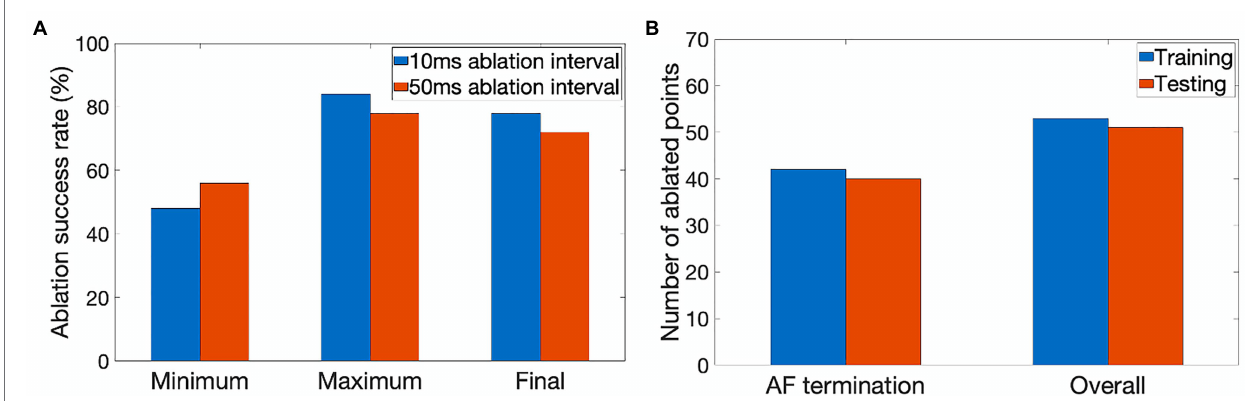
FIGURE 4 | Performance characteristics of the ablating agent. (A) The minimum, maximum and final ablation success rate achieved during training for 10 ms (blue) and 50 ms (orange) ablation intervals. (B) Average number of ablated points (9 × 9 pixel lesions) in cases when AF was terminated successfully and the overall number of cases during training (blue) and testing (orange).